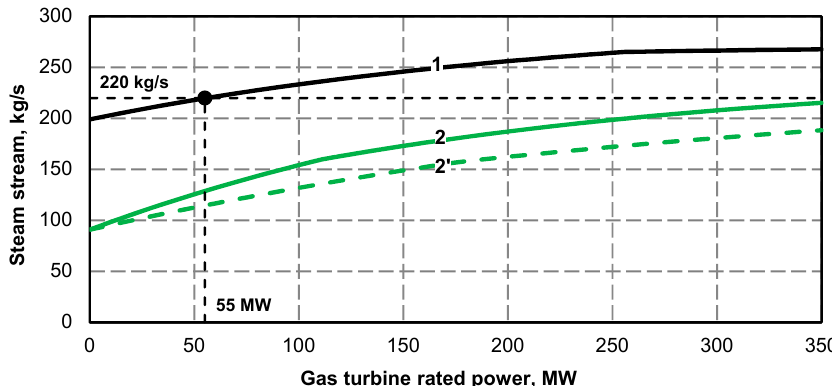
Figure 14. The stream of outlet steam from the low-pressure steam turbine part to the KQ1 condenser as a function of gas turbine rated power: 1 — maximum fixed stream of 319.4 kg/s fresh steam fed to steam turbine; 2 — minimum steam boiler output of 133.3 kg/s and gas turbine operating at a rated power, 2’ — minimum steam boiler output of 133.3 kg/s and gas turbine operating with 60% of its rated power.